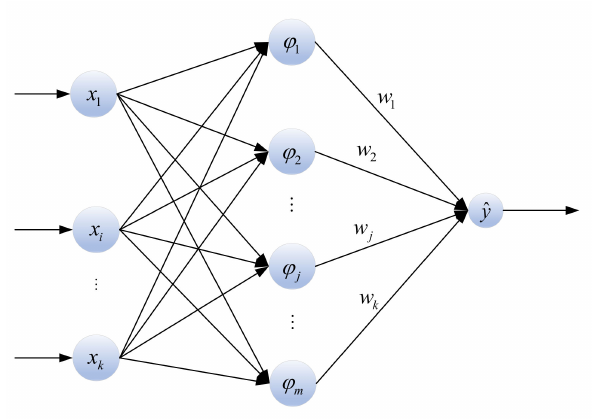
Figure 1. The structure of